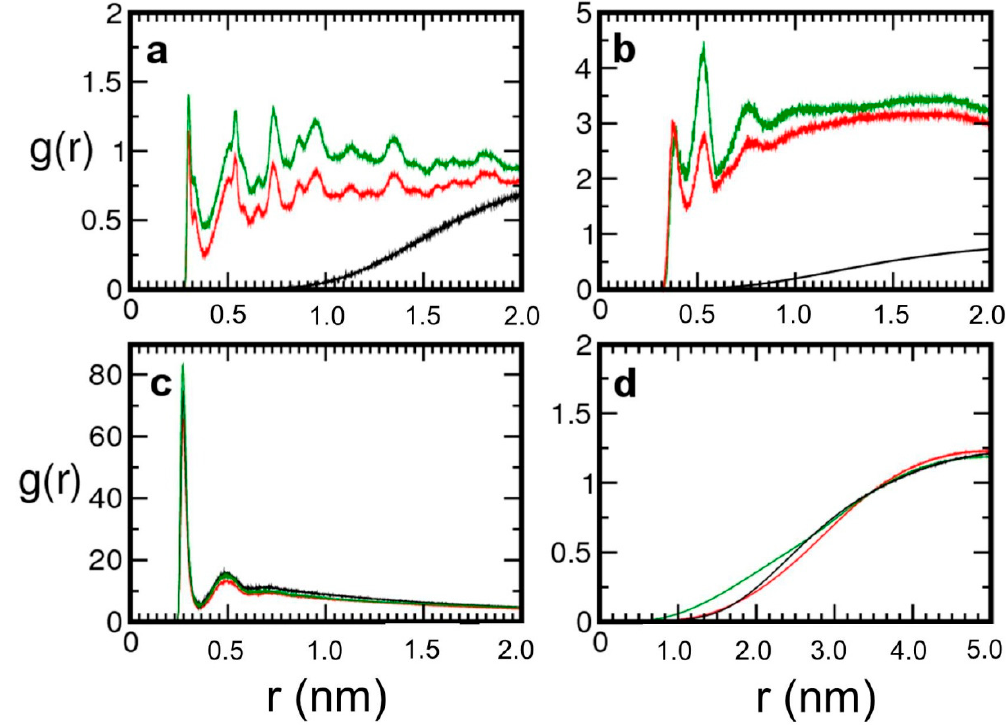
Figure 2. Radial distribution functions g(r) calculated for the simulations with the neutral channel (Model 1, black lines), with the charged channel (Model 2, red lines) and with the charged channel and a lower number of water molecules (Model 3, green lines). Panel ( a ) surface silanols–potassium ions radial distribution functions; panel ( b ) Silanols-water oxygen (Model 1) and silanolates–water oxygens (Models 2 and 3) radial distribution functions; panel ( c ) water oxygens–cations radial distribution functions; panel ( d ) surface silanols–pepsin atoms radial distribution functions.